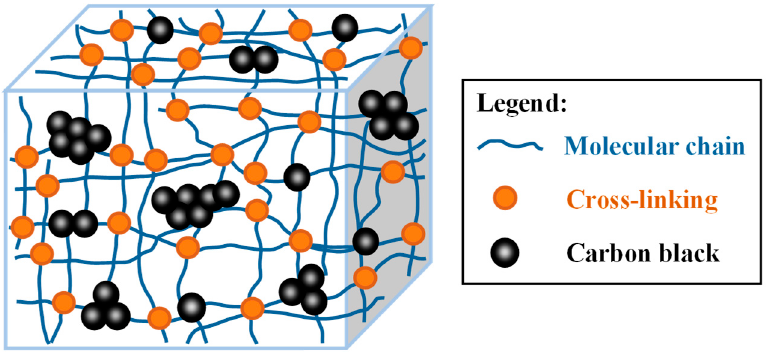
Figure 1. Illustration of microstructure of a carbon black filled rubber.